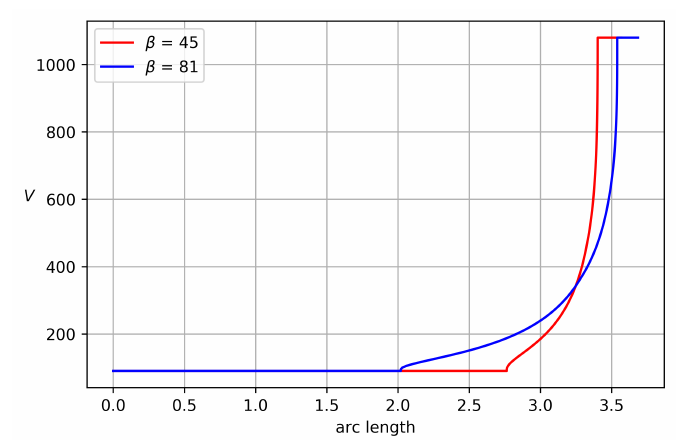
Figure 6. Velocity magnitude along the nozzle